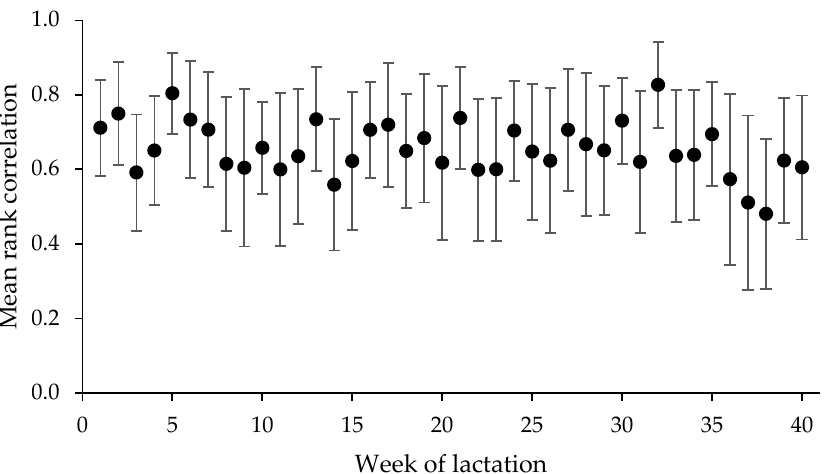
Figure 3. Rank correlation of CH 4 emissions (with s.e. bars) in grams per minute across lactations.